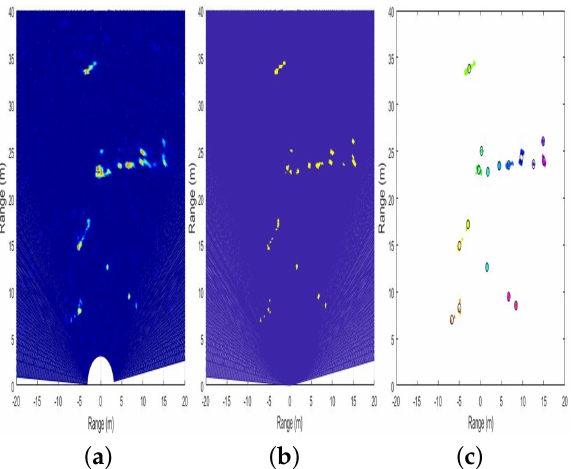
Figure 6. Preprocessing for the input radar signal: ( a ) converted radar image in Cartesian coordinate system; ( b ) radar image after applying OS-CFAR; and ( c ) final clustering result from DBSCAN.